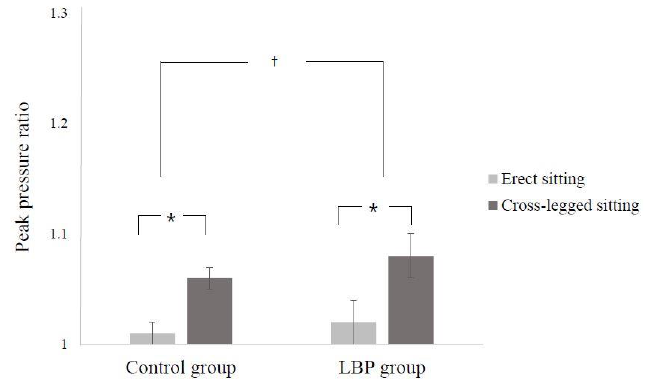
Figure 3. Mean (standard deviation) of pelvic obliquity during two different sitting postures.